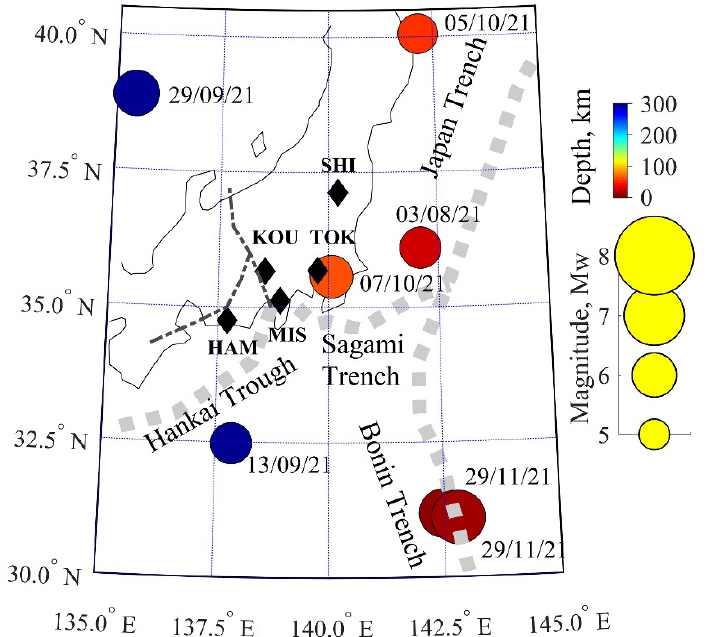
Figure 3. Map of JMA weather stations (SHI, TOK, MIS, KOU, HAM), together with deep-sea trenches, crust faults, and EQs with magnitude >5.7 that occurred during July–December 2021. This shows the epicenter of our EQ that occurred on 7 October, as well as the TOK weather station located within Tokyo.